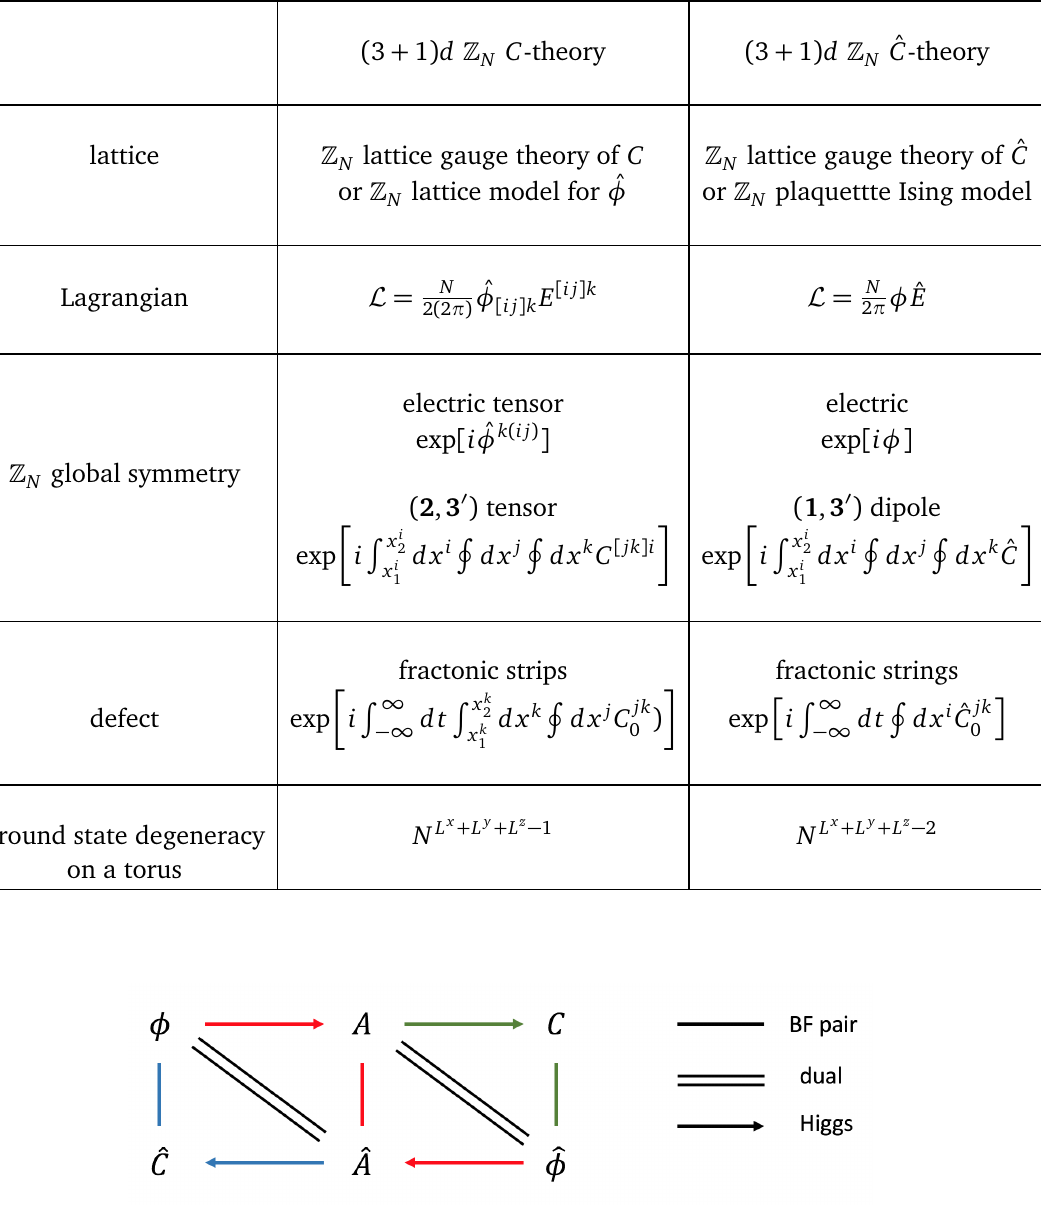
gauge N C -theory of N